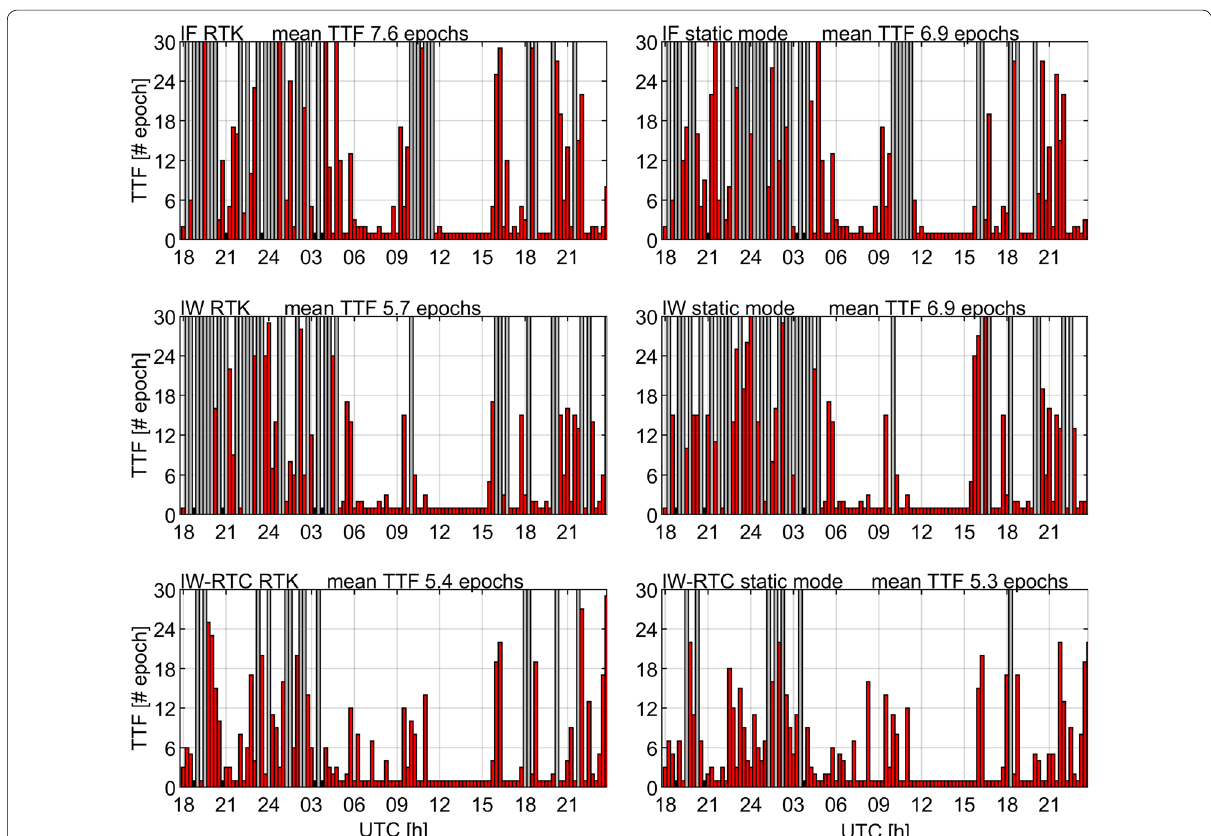
Fig. 8 Time to first fix for RTK (left column) and rapid static (right column) modes obtained in the consecutive sessions during high ionospheric activity given for IF (top panels), IW (middle panels) and IW-RTC models (bottom panels). Black bars depict sessions without a solution, grey ones correspond to the sessions which were not correctly fixed within the 30 epoch time limit